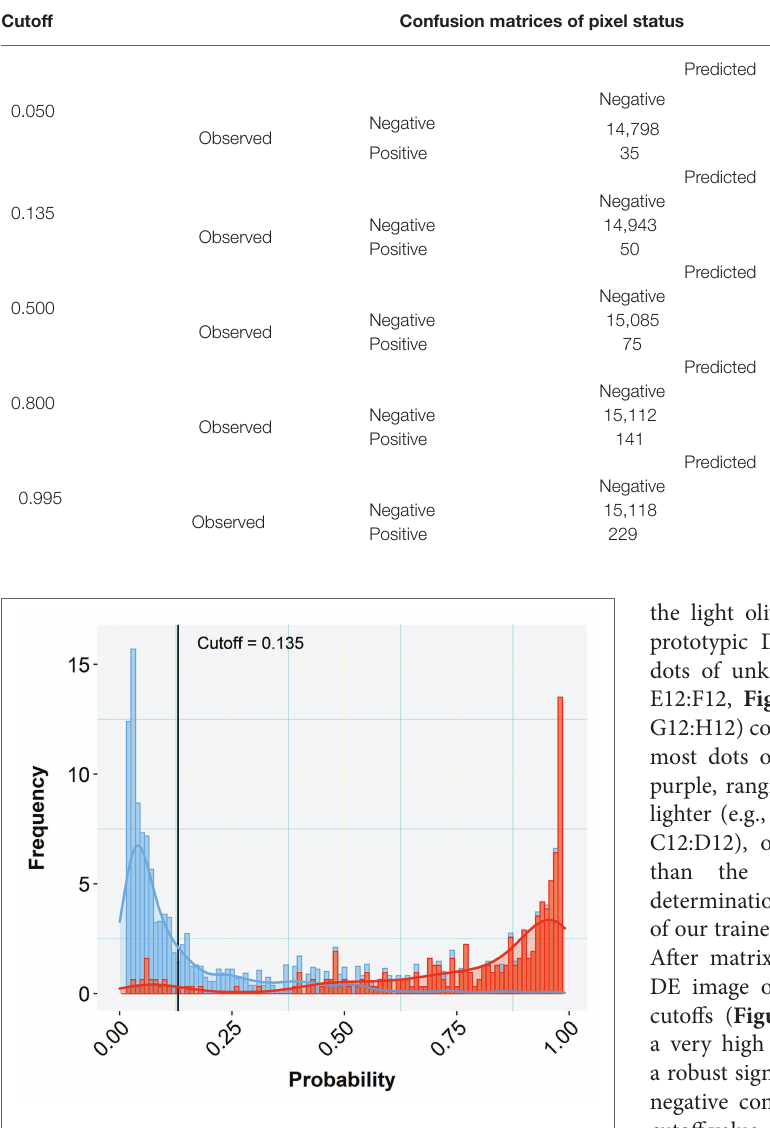
FIGURE 5 | Histogram of stacked bars and the corresponding density curves showing the frequencies and density of classified pixels of the test subset of the prototypic image as negative (blue) or positive (orange). The length of each bar is proportional to the number of classified pixels at each probability class (defined by the bar width). The picture zooms at the range of probabilities between 0.05 and 0.99, concealing the high proportions of negatives (near zero) and positives (near one) to emphasize the overlapping between misclassified pixels. The black vertical line crossing at the selected cutoff (0.135 in this case) divides the plot into two halves that represent negative (below the cutoff) and positive (above the cutoff) predicted pixels. As the vertical line moves to the right (increasing cutoff), more TN are collected (blue bars to the right) at the cost of considering some orange bars (TP) as negatives (TN or specificity increase). When the line moves to the left (decreasing cutoff) more TP (orange bars) are detected at the cost of misconsidering some blue bars (TN) as orange (positives; TP or sensitivity increase). Selecting the appropriate cutoff for each diagnostic case is unavoidably a compromise that minimizes the effects of the least important error